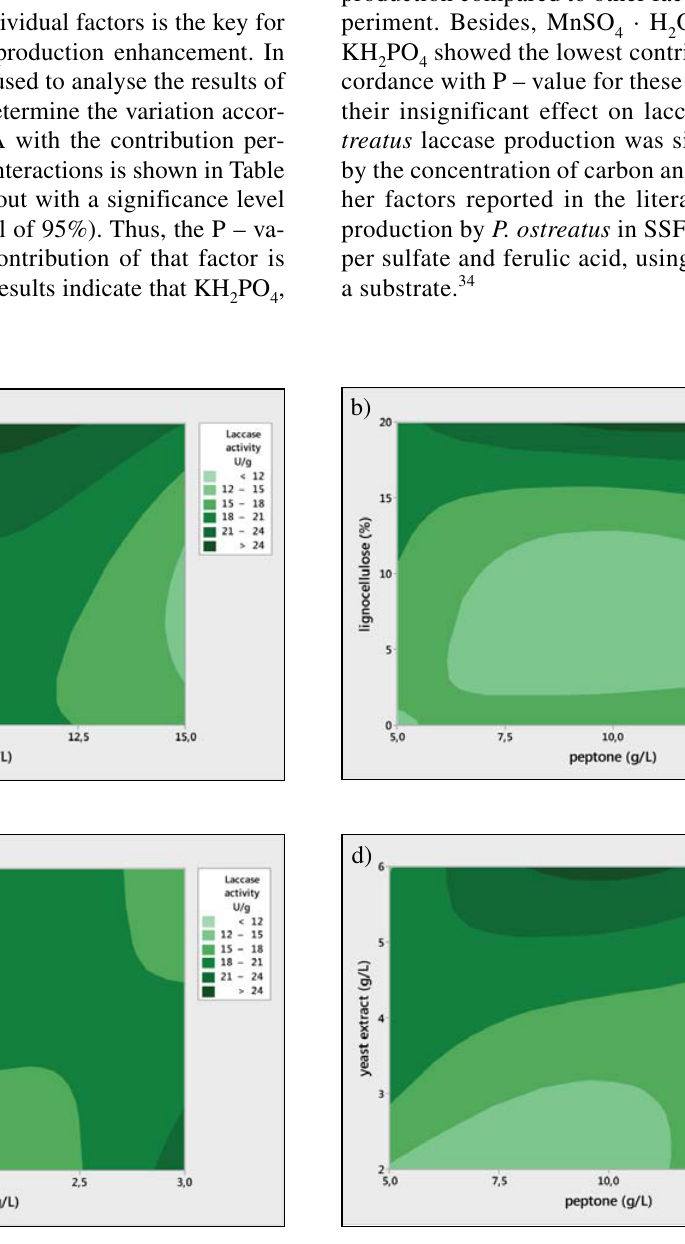
Figure 1: Contour plots of the interactive effects of: (a) LB and glucose, (b) LB and peptone, (c) glucose and KH tone on laccase